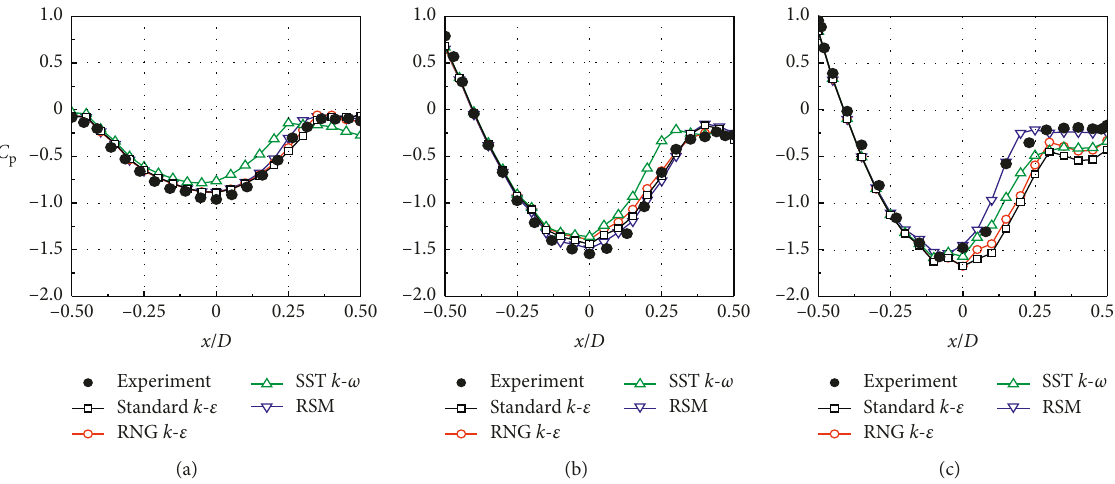
Figure 5: Experimental and numerical mean pressure distributions on the middle transverse cross sections of the cylindrical roof. (a) R / S � 1/6. (b) R / S � 1/3. (c) R / S � 1/2.